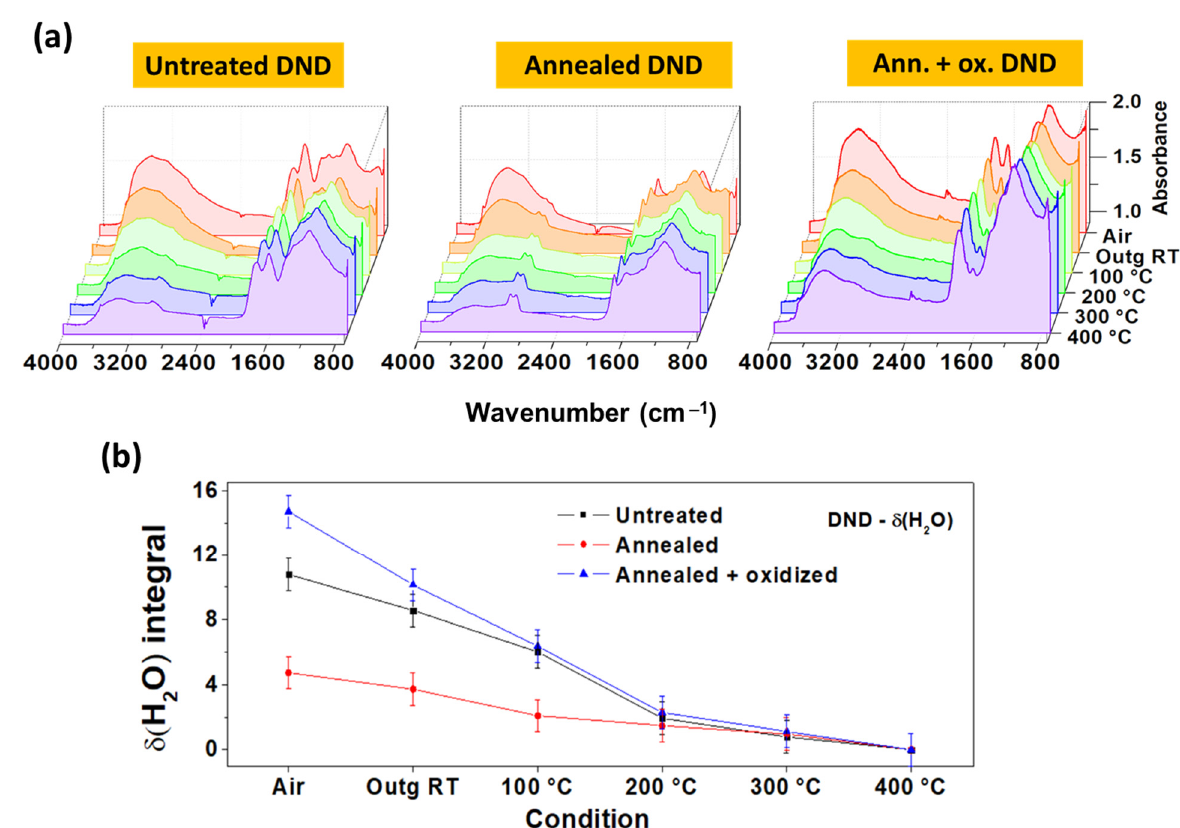
Figure 3. ( a ) DRIFT spectra of untreated, annealed, and annealed + oxidized DNDs as a function of the applied temperature; ( b ) δ (H 2 O) band integral as a function of the acquisition condition for untreated, annealed, and annealed + oxidized DNDs.